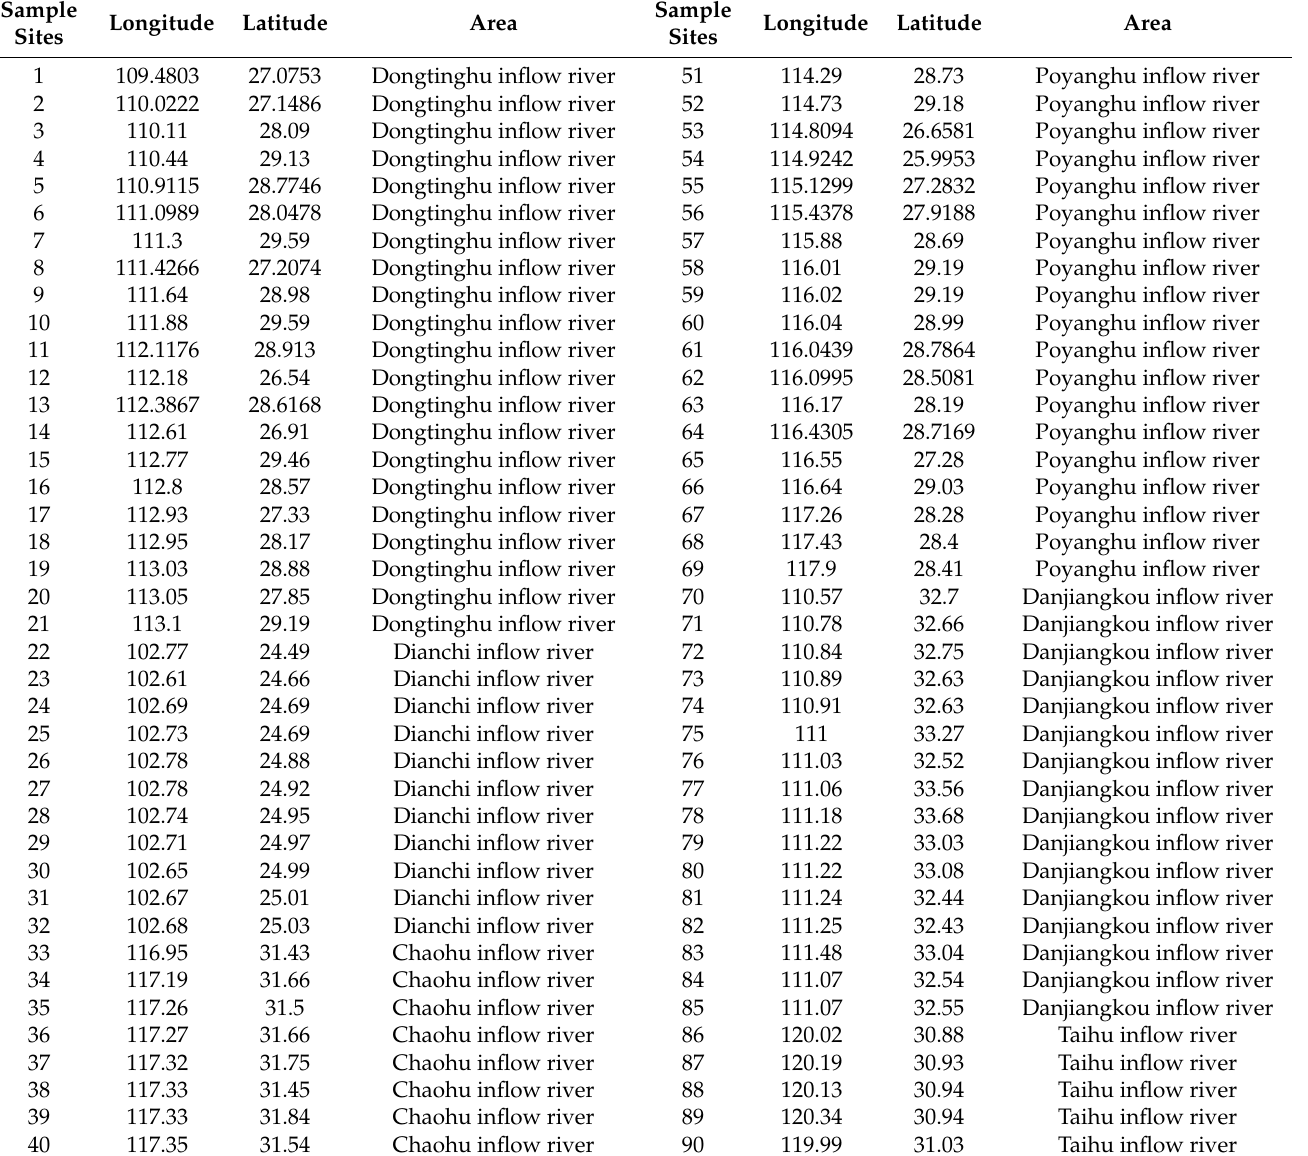
Table 1. Information of sampling